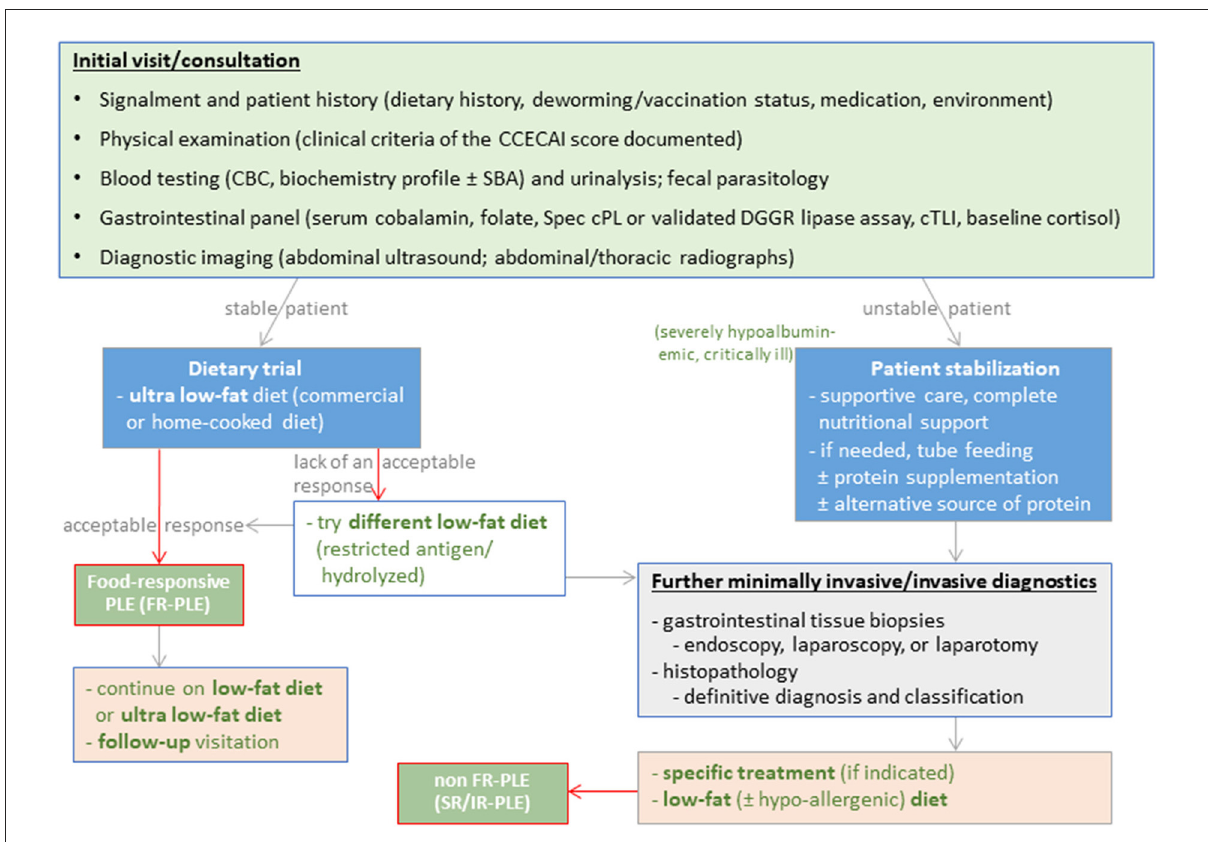
FIGURE5 Diagnostic and therapeutic approach to dogs with protein-losing enteropathy